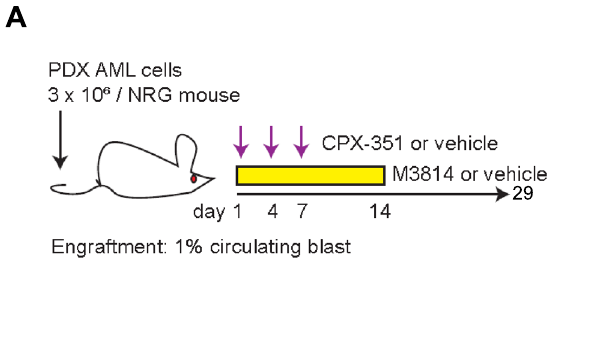
(Fig. 7B). During the 29-day observation period, the combined CPX-351/M3814 treatment showed no significant body weight changes (Fig. 7C) or reduction in hemoglobin and platelets levels (Fig. 7D), suggesting that addition of DNA-PK inhibitor to the optimized chemotherapy formulation CPX-351 provides a superior anti-leukemia effect while sparing normal hematopoietic cells.